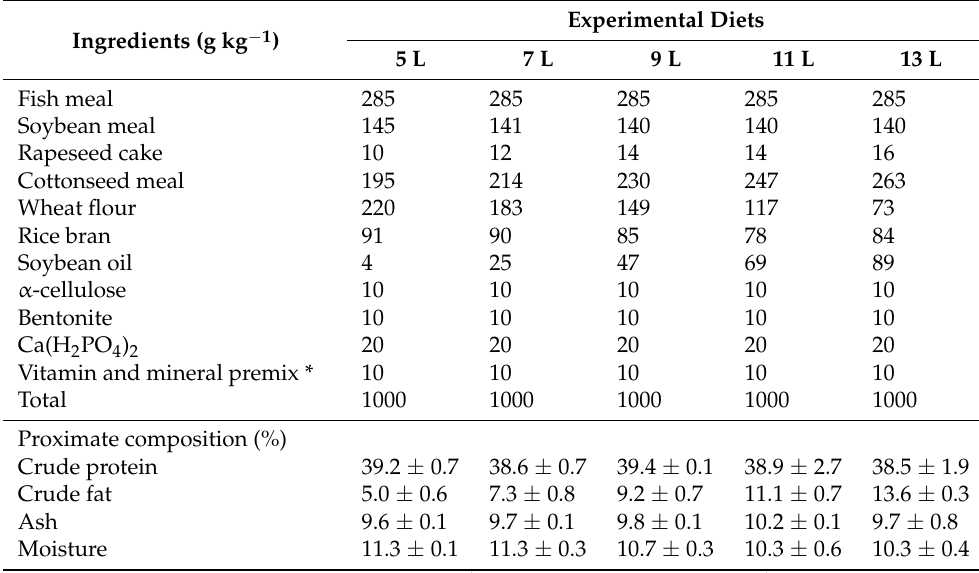
Table 1. Ingredients (g kg − 1 , dry weight) and proximate composition (air dry basis, %) of experimen- tal diets differ in their total crude